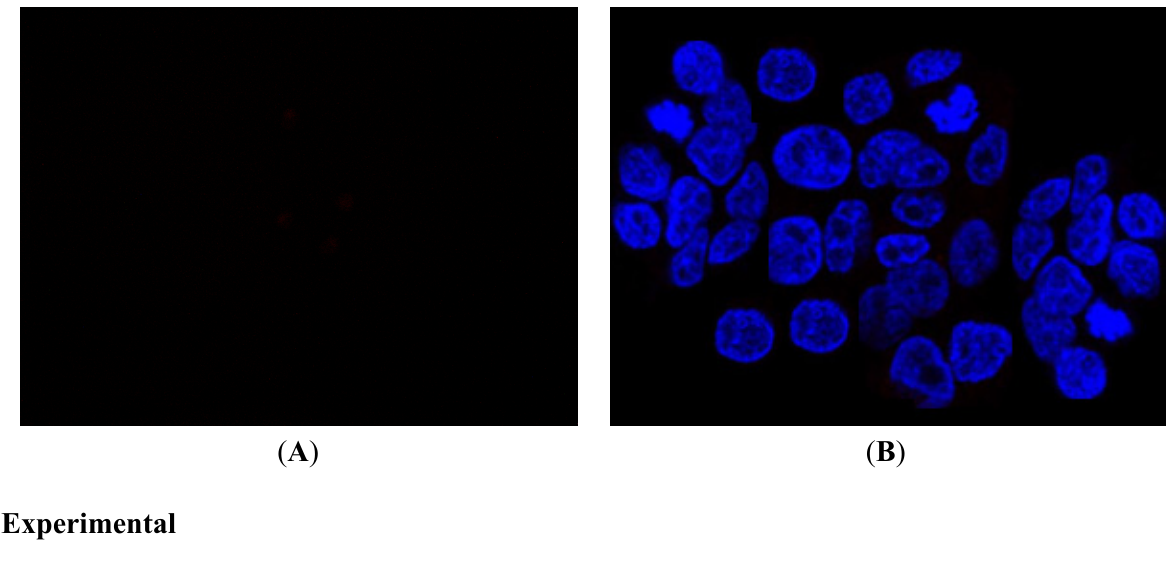
Figure 11. Fluorescent images of human epithelial colorectal adenocarcinoma HCA-7 cultures untreated ( A ) or treated with derivative 4 ( B